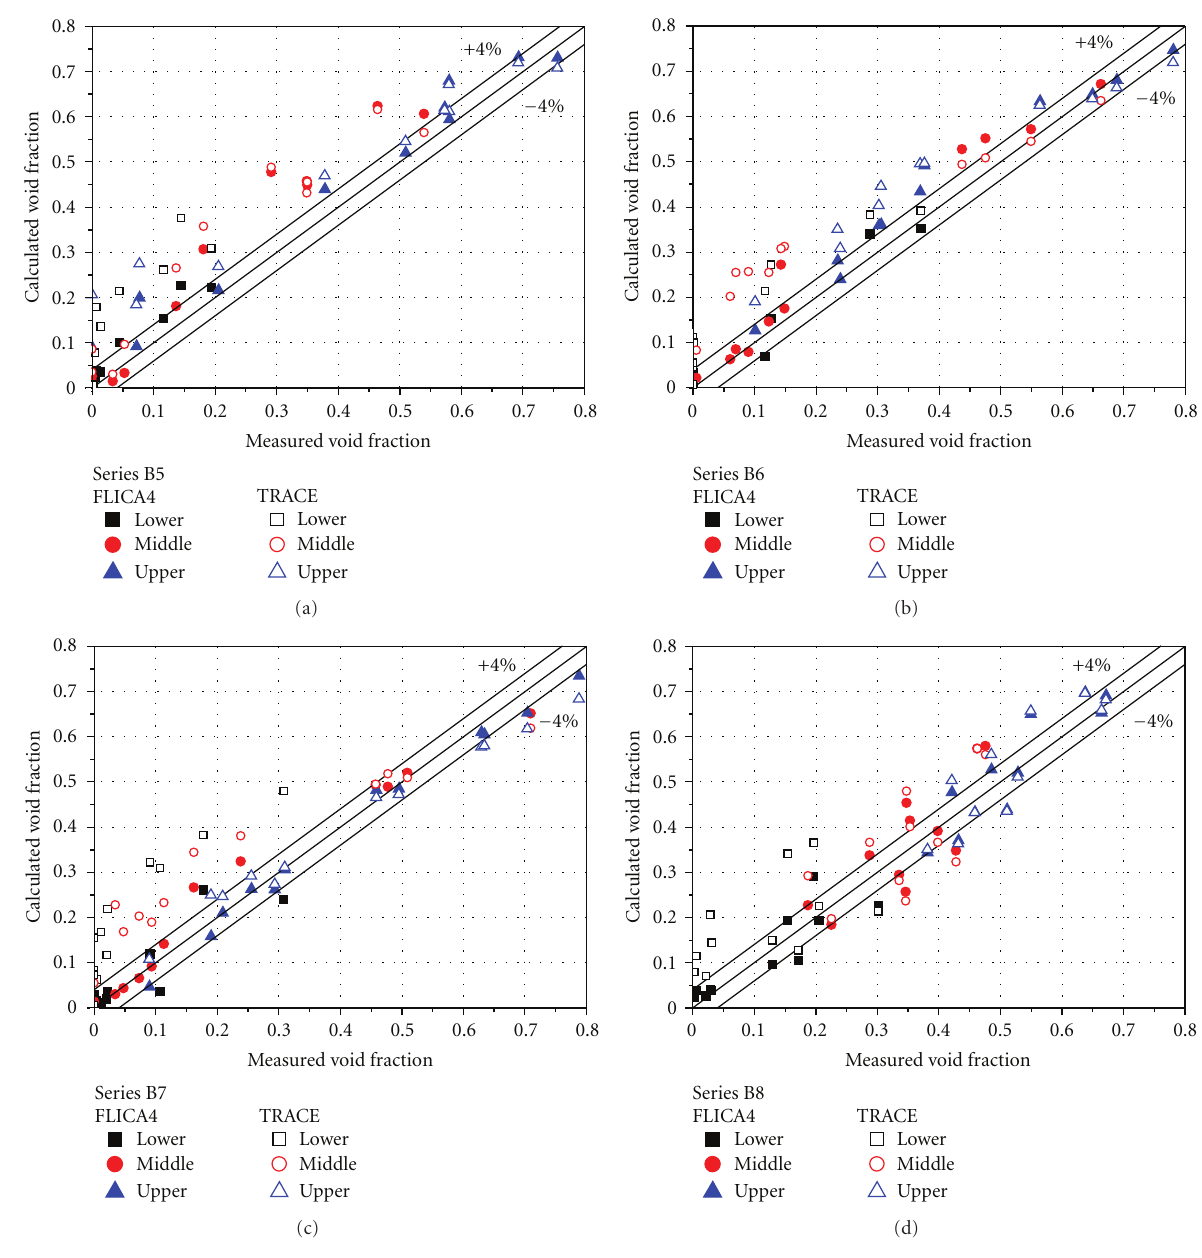
Figure 13: Void fraction of bundle